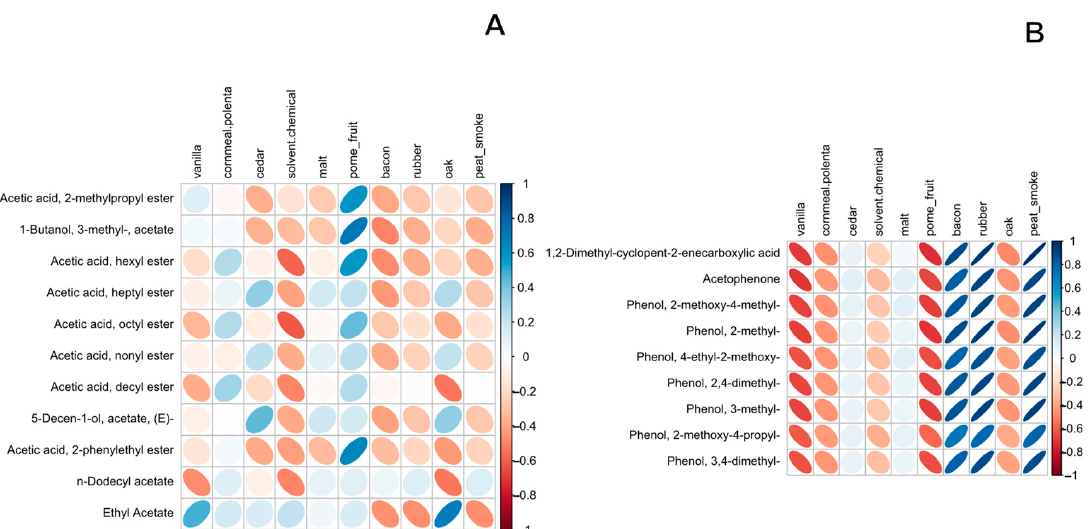
Figure 4. Correlograms of “acetate ester” ( A ) and “phenol” ( B ) compound classes with sensory at- tributes. Irregularity of ellipsis shape corresponds to the correlation coefficient while color represents positive/negative correlation (red = negatively correlated, blue = positively correlated). Volatile compound data were measured in triplicate by HS-SPME-GC-MS and tentatively identified using the NIST 2020 library, triplicate measures were averaged for comparison. Sensory attributes are averaged duplicate measures recorded by trained descriptive analysis (DA) sensory panel ( n = 20). Partial least squares discriminant analyses (PLS-DA) were used to determine overall associations between whisky style and sensory descriptors used by the trained panel and by dilution factor (Figure 5).